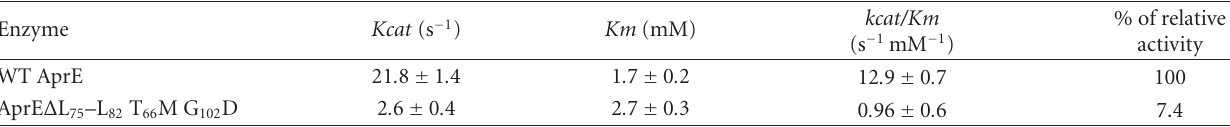
Table 2: Kinetic parameters of AprE and AprE Δ L 75 –L 82 T 66 MG 102 D during hydrolysis of s-AAPF- p Na. Reactions were carried out in 100 mM Tris-HCl, pH 8.0, 5 mM CaCl 2 , at 37 ◦ C, using as substrate s-AAPF- p Na. Values are triplicate determinations in two separate experiments ± SD.